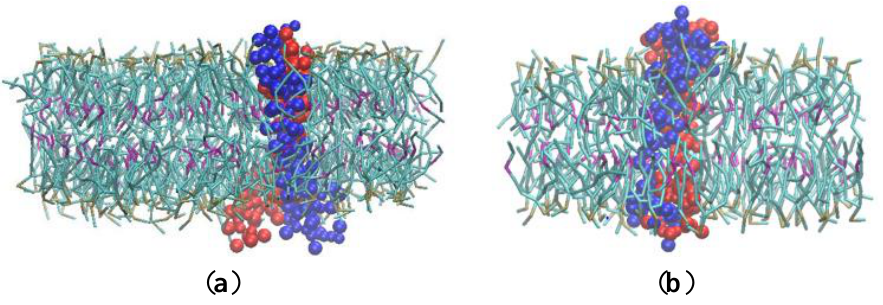
Figure 7. ( a ) A dimer with a left-hand structure. ( b ) A dimer with a right-hand